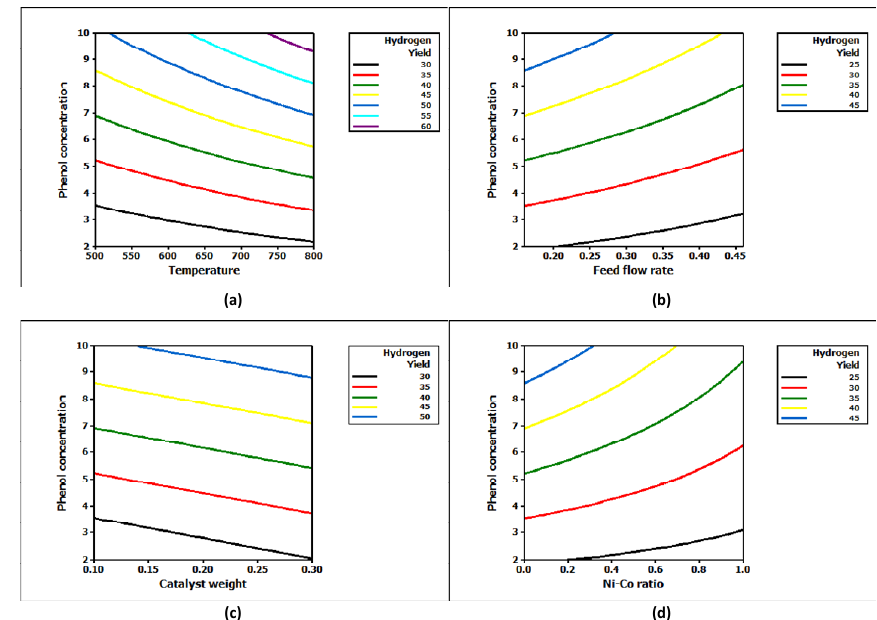
Figure 14. Contour plot for significant interactions on Y 2 : ( a ) AE ; ( b ) BE ; ( c ) CE ; ( d ) DE .